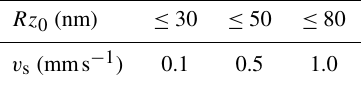
Table 1. Scanning speed values and related Rz 0 according to DIN EN ISO 3274 (1996), Lc = 0.25mm, Lc / Ls = 100.